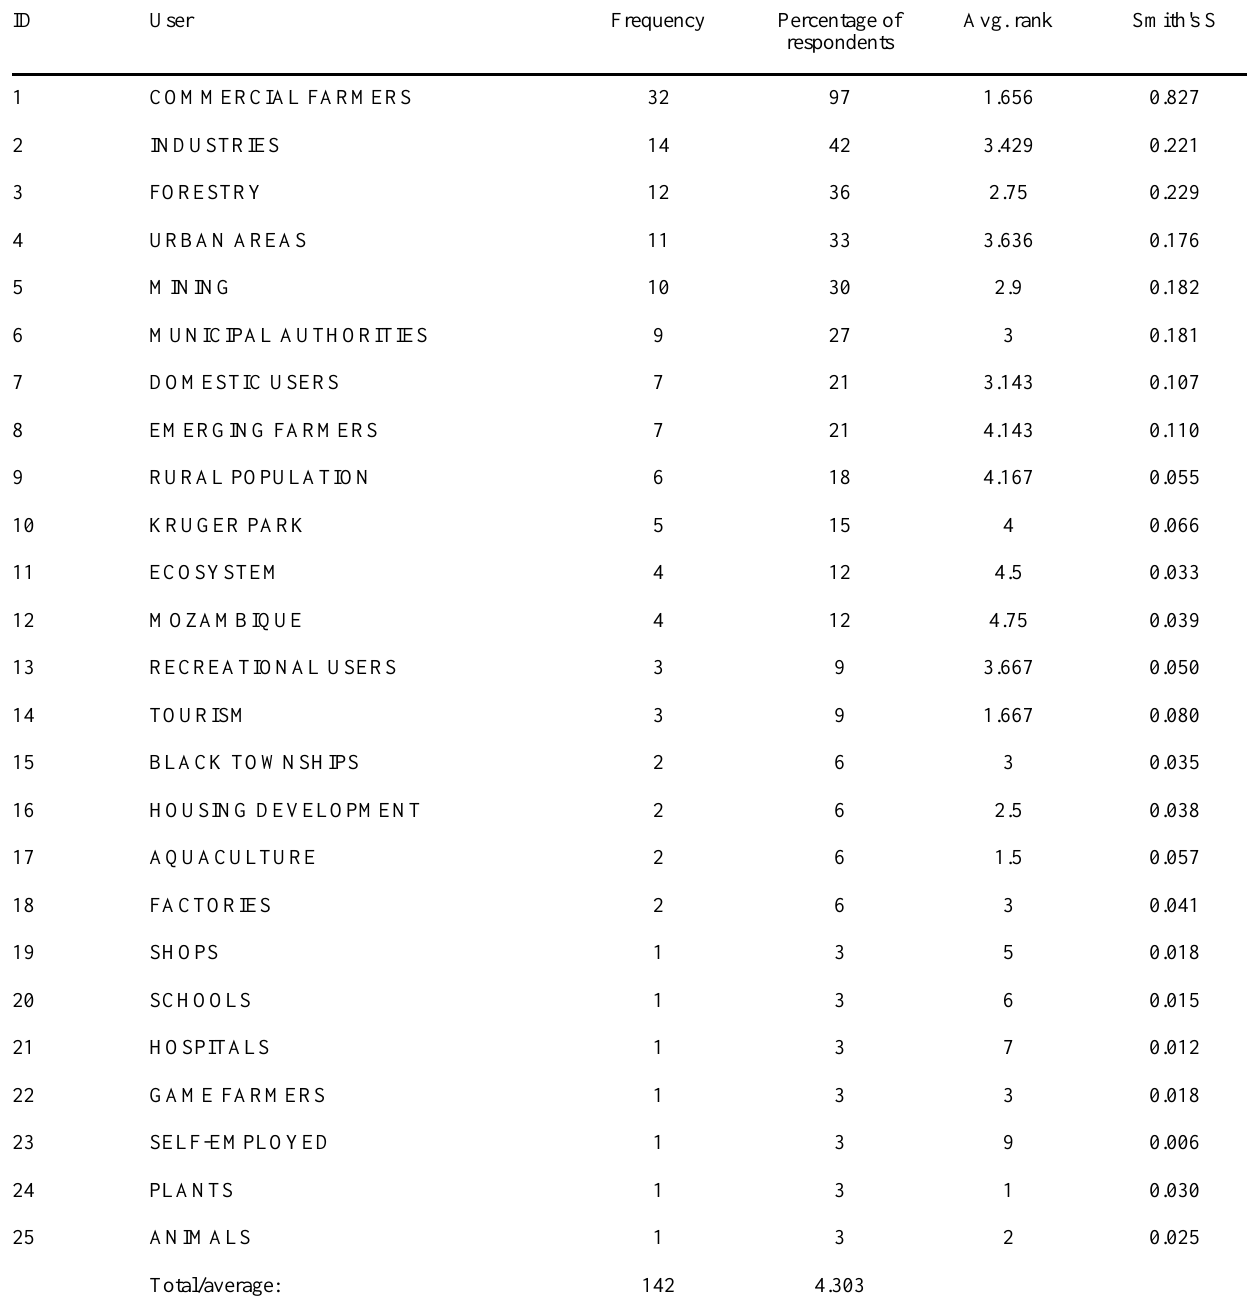
Table 2 . Results of analysis of freelists of “major users of water”, showing frequency with which interviewees identified users, the percentage of interviewees who identified that user, the average ranking of that user and the salience (Smith's S) of the